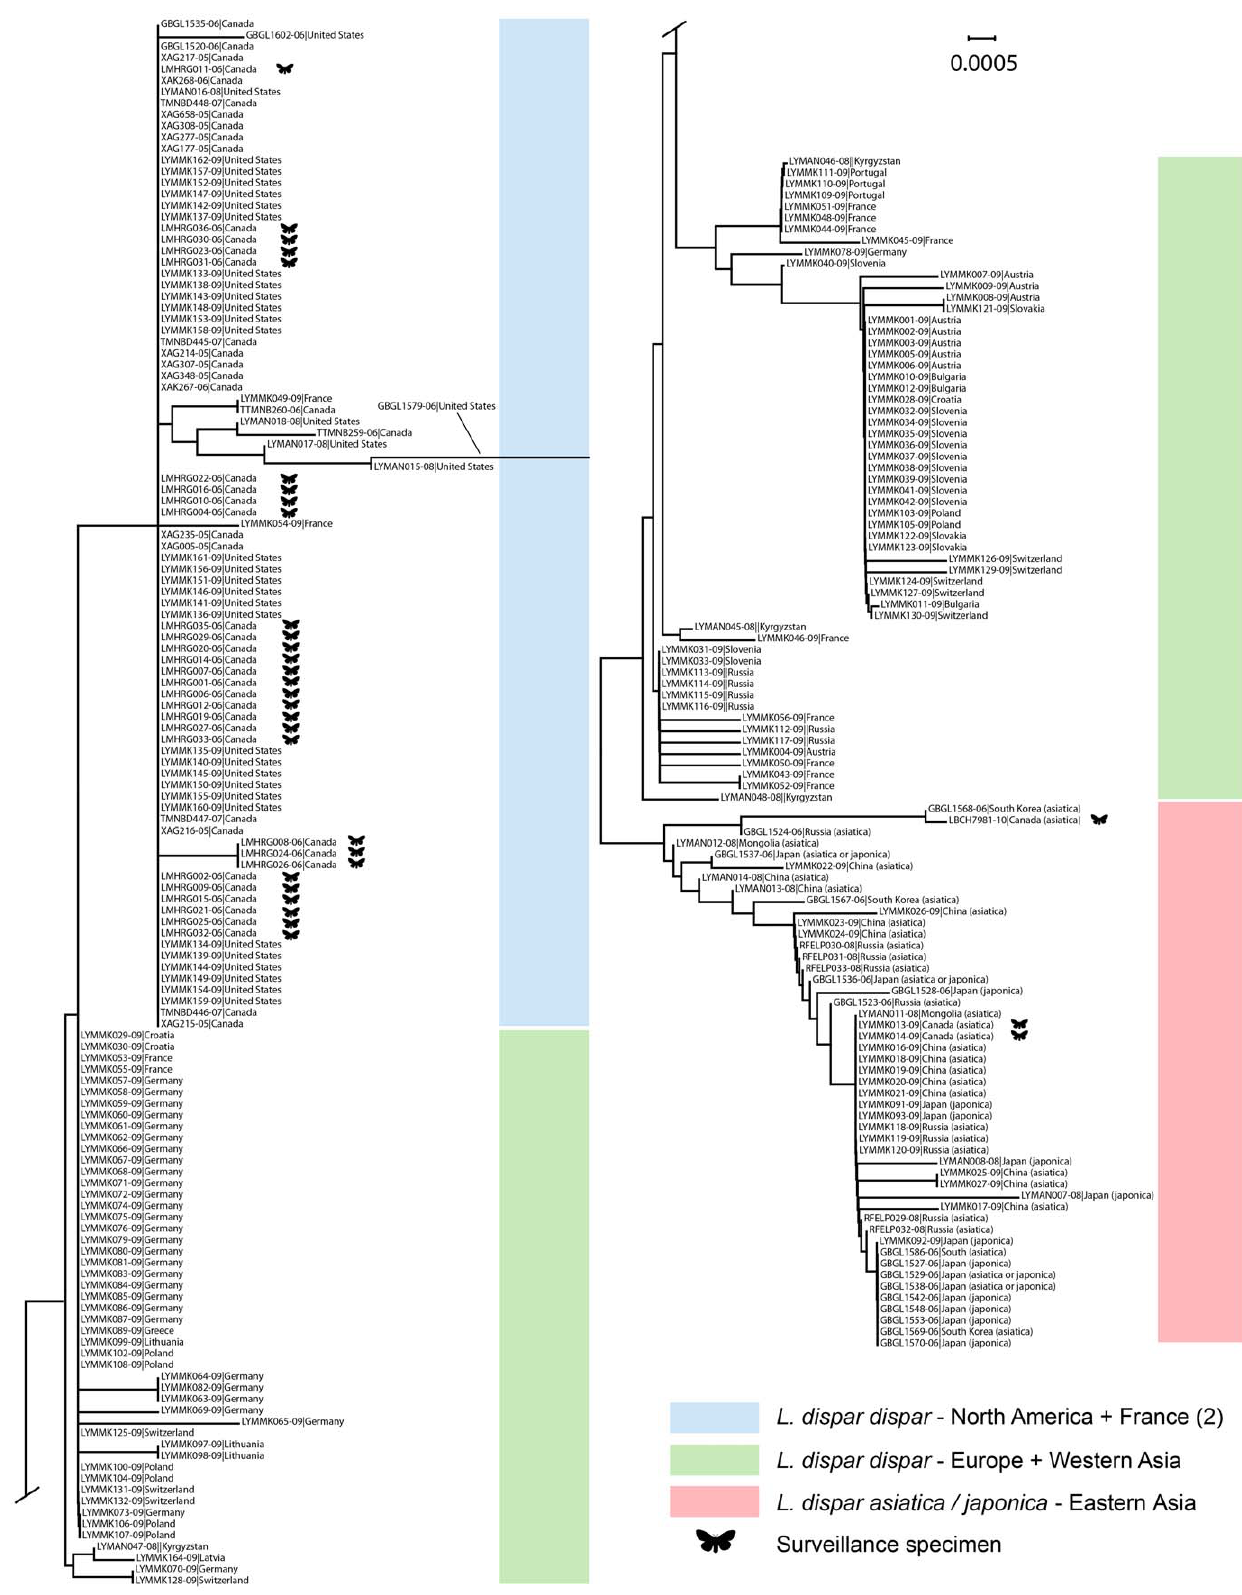
Figure 5. Neighbour-joining tree of the gypsy moth Lymantriadispar . Tree was constructed with 244 sequences of the COI barcode region. BOLD process IDs and collection localities are provided for each sequence. Surveillance specimens are denoted by a moth symbol.